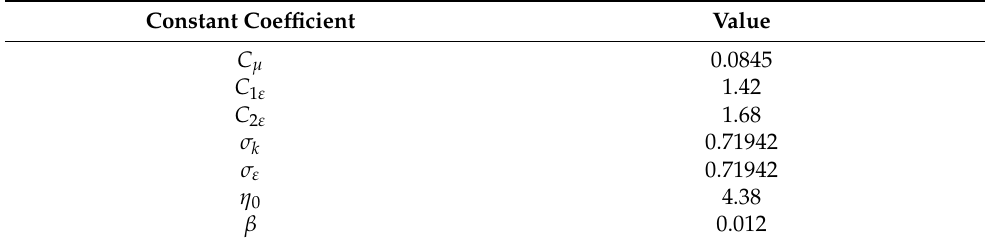
Table 1. Value of constant coefficients in the RNG k- ε turbulence